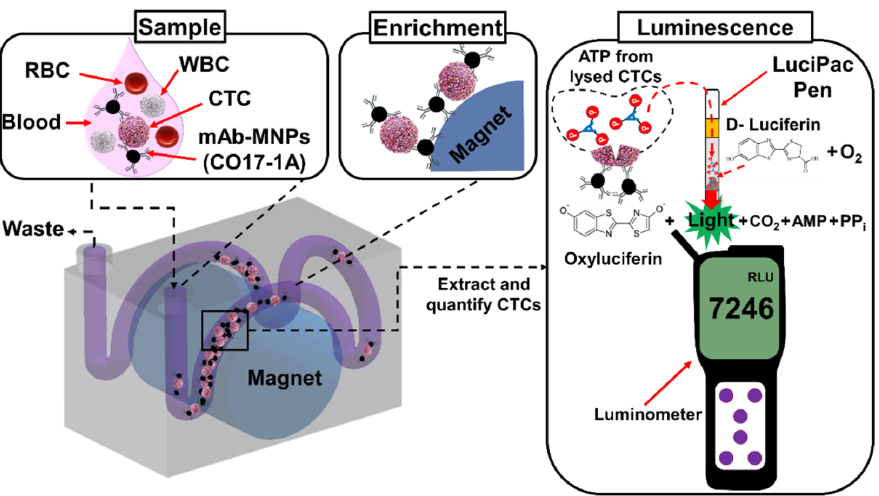
Figure 1. Schematics describing the selective enrichment of CTCs in blood using 3DPIC, followed by their detection using the ATP luminescence assay. CTCs in blood are enriched with MNPs